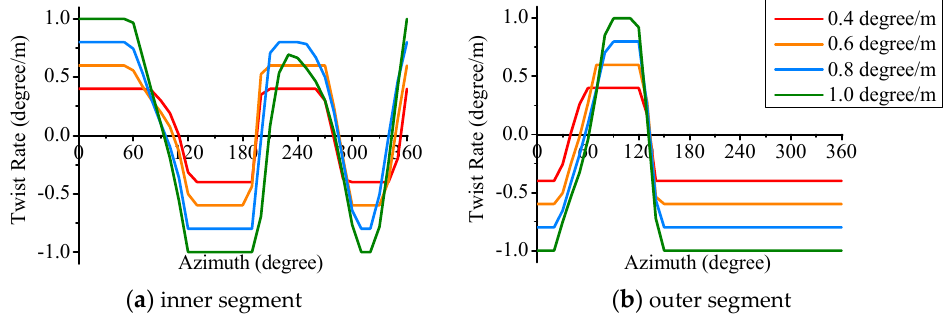
Figure 29. Optimal control schedules of the 2-seg control with saturation limits for condition B.